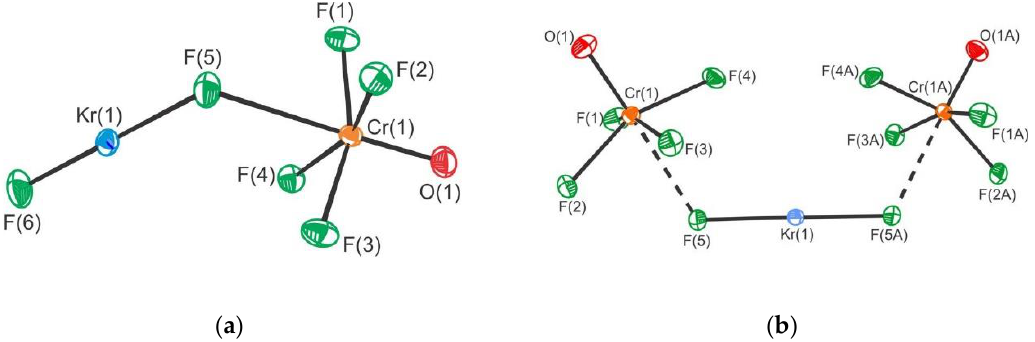
Figure 20. ( a ) The X-ray crystal structures of the near-staggered conformation of KrF 2 · CrOF 4 ; ( b ) The structural unit in the X-ray crystal structure of syn-KrF 2 · 2CrOF 4 . Copyright (2019) Wiley. Used with permission from Ref. [28].